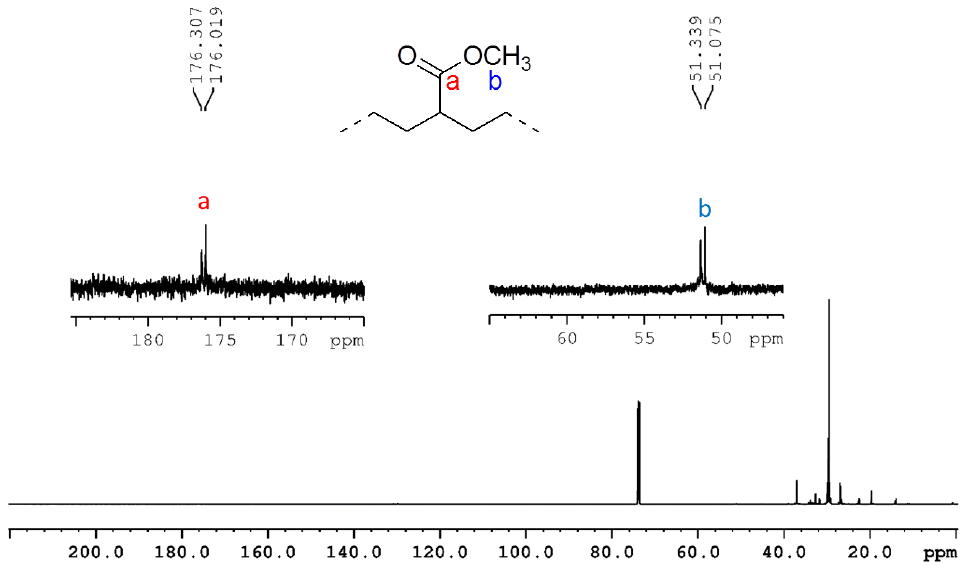
Figure 2. 13 C NMR (C 2 D 2 Cl 4 , 150 MHz, T = 298 K) spectrum of the copolymer sample of run 2, Table 1.